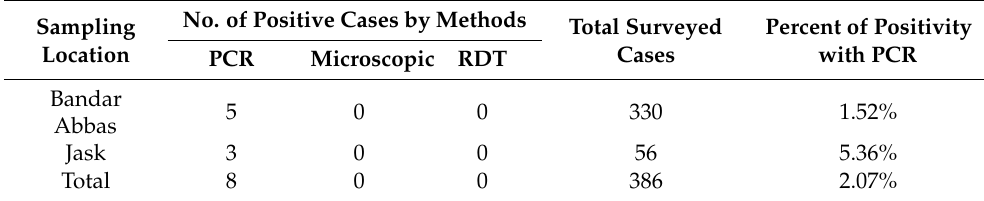
Table 3. Positive cases according to sampling location among immigrants in an asymptomatic malaria study.